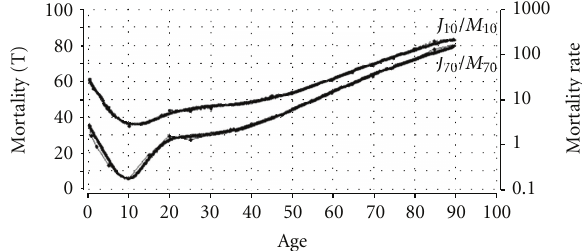
Figure 6: Life trajectory simulation of fluid (Gf) and crystallized (Gc) intelligence (dotted) with the Janus model (bold): Jf = fluid; Jc = crystallized [11, 28].